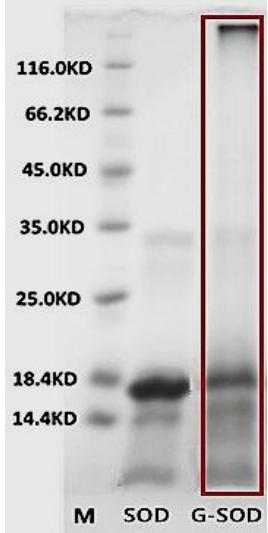
Figure 1. Sodium dodecyl sulfate-polyacrylamide gel electrophoresis (SDS-PAGE) pattern of superoxide dismutase (SOD) and the co-incubated reactant of Cu/Zn SOD and glucose (G-SOD).